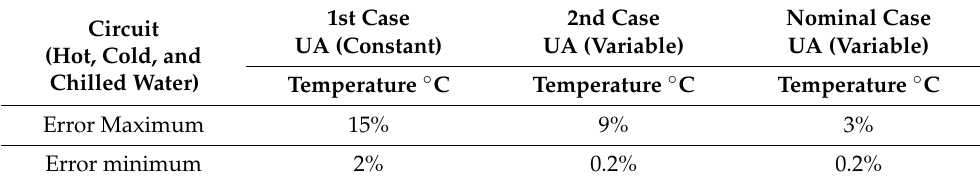
Table 6. Validation of the thermodynamic modeling by experimental data. Adapted from Ochoa et al. [82] (Reprinted with permission from